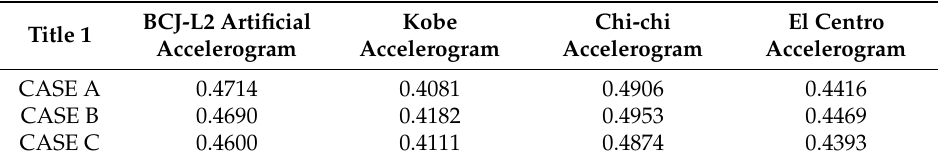
Table 5. Normalized maximum controlled structural drift